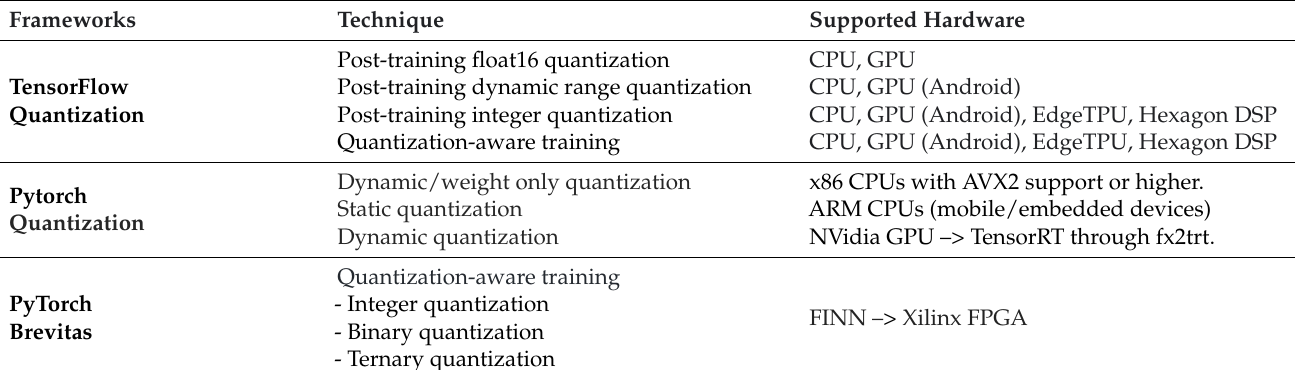
Table 1. The table above gives us a general idea of the frameworks for quantized neural